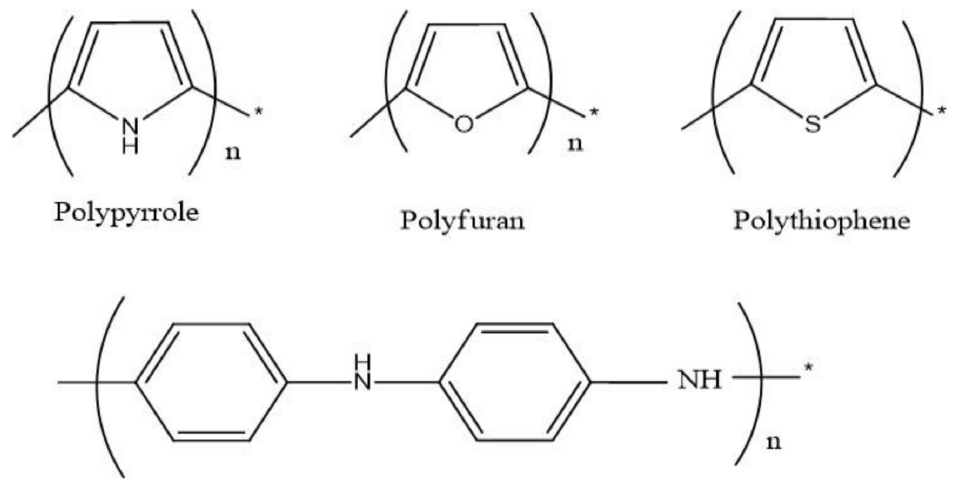
Figure 1. Intrinsically conducting polymers. Reproduced with permission from